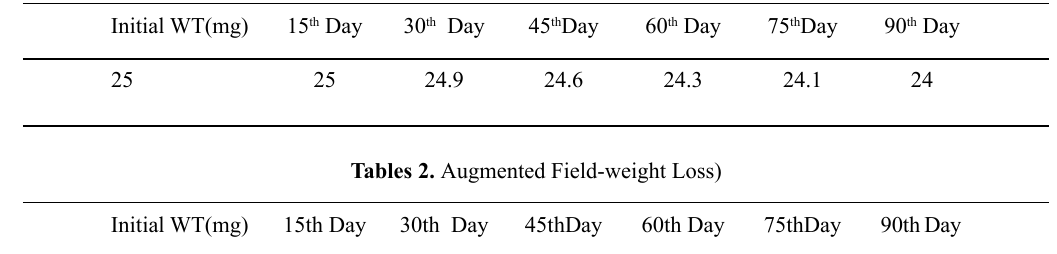
table 1. Control Field-weight Loss)